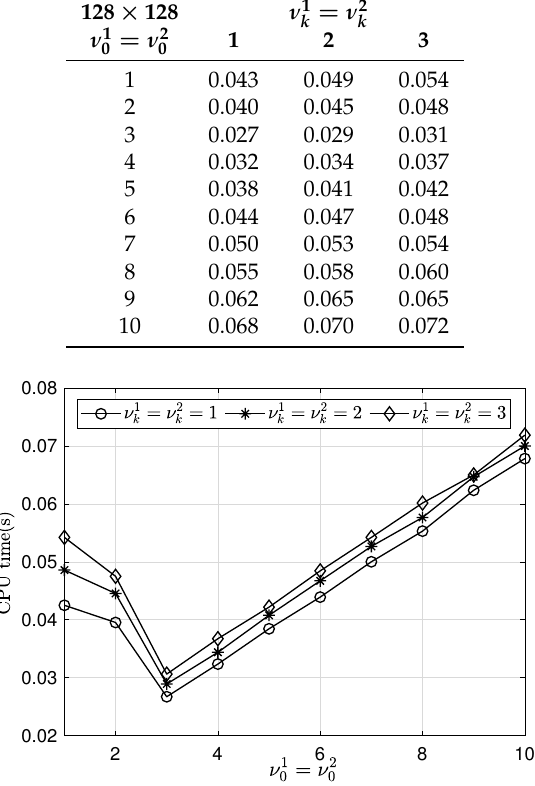
Figure 9. Average CPU times for various relaxation numbers on finest multigrid level ( ν 1 relaxation number 1,2 and 3 on other grids with a 128